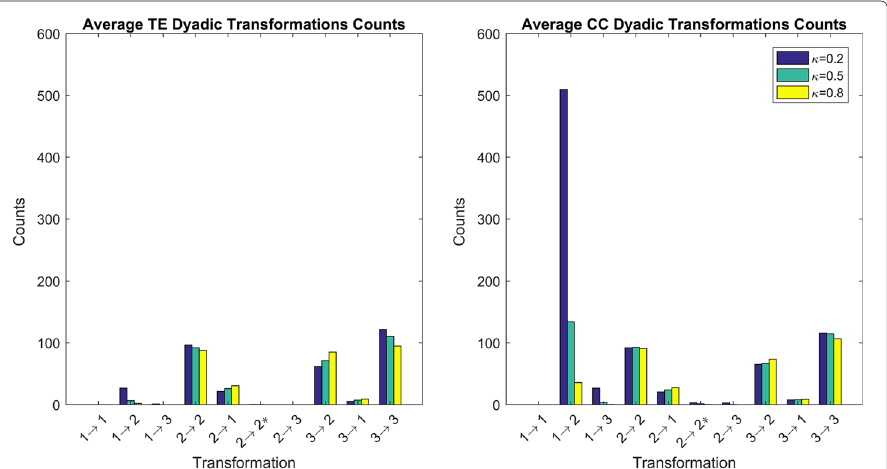
Fig. 5 Average Dyadic Transformation Counts. Average dyadic transformation counts for TE and CC methods over all 10 trails. We notice the significantly higher number of counts for FP involving transformations 1 →